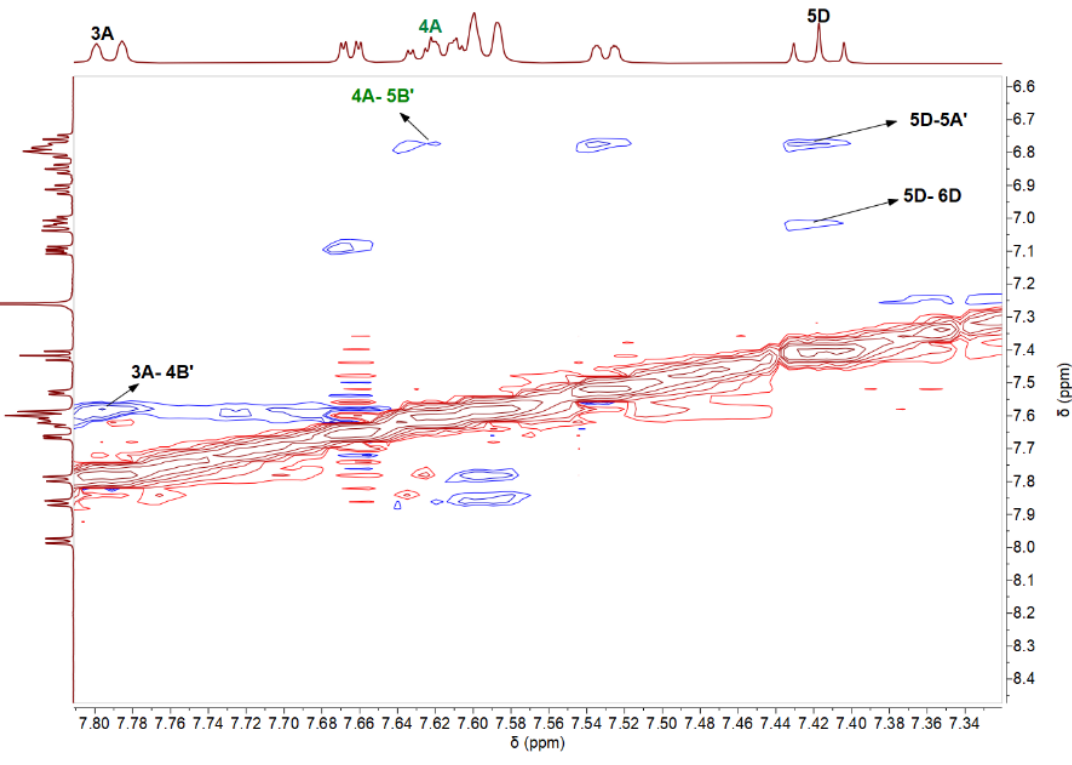
Figure 7. Vital NOESY correlations of IrQ(ppy) 2 .